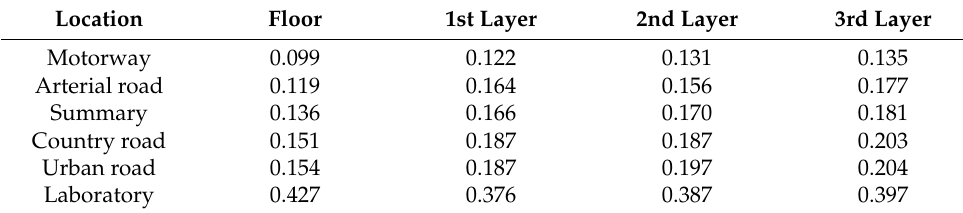
Table 3. Overall G rms of various layers and the source of data (1–200